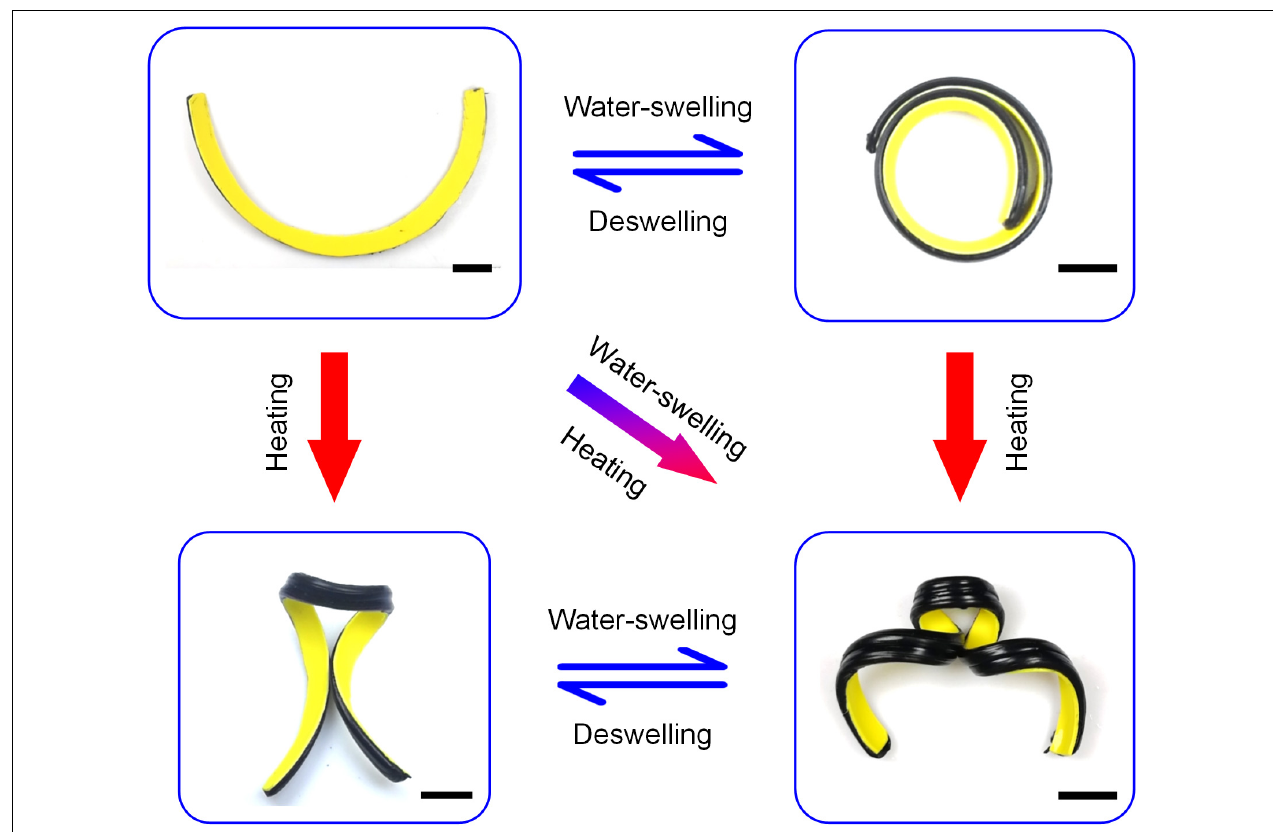
FIGURE 10 | Deformation of a PU-SMPVC bilayer structure with a semicircular shape in response to different